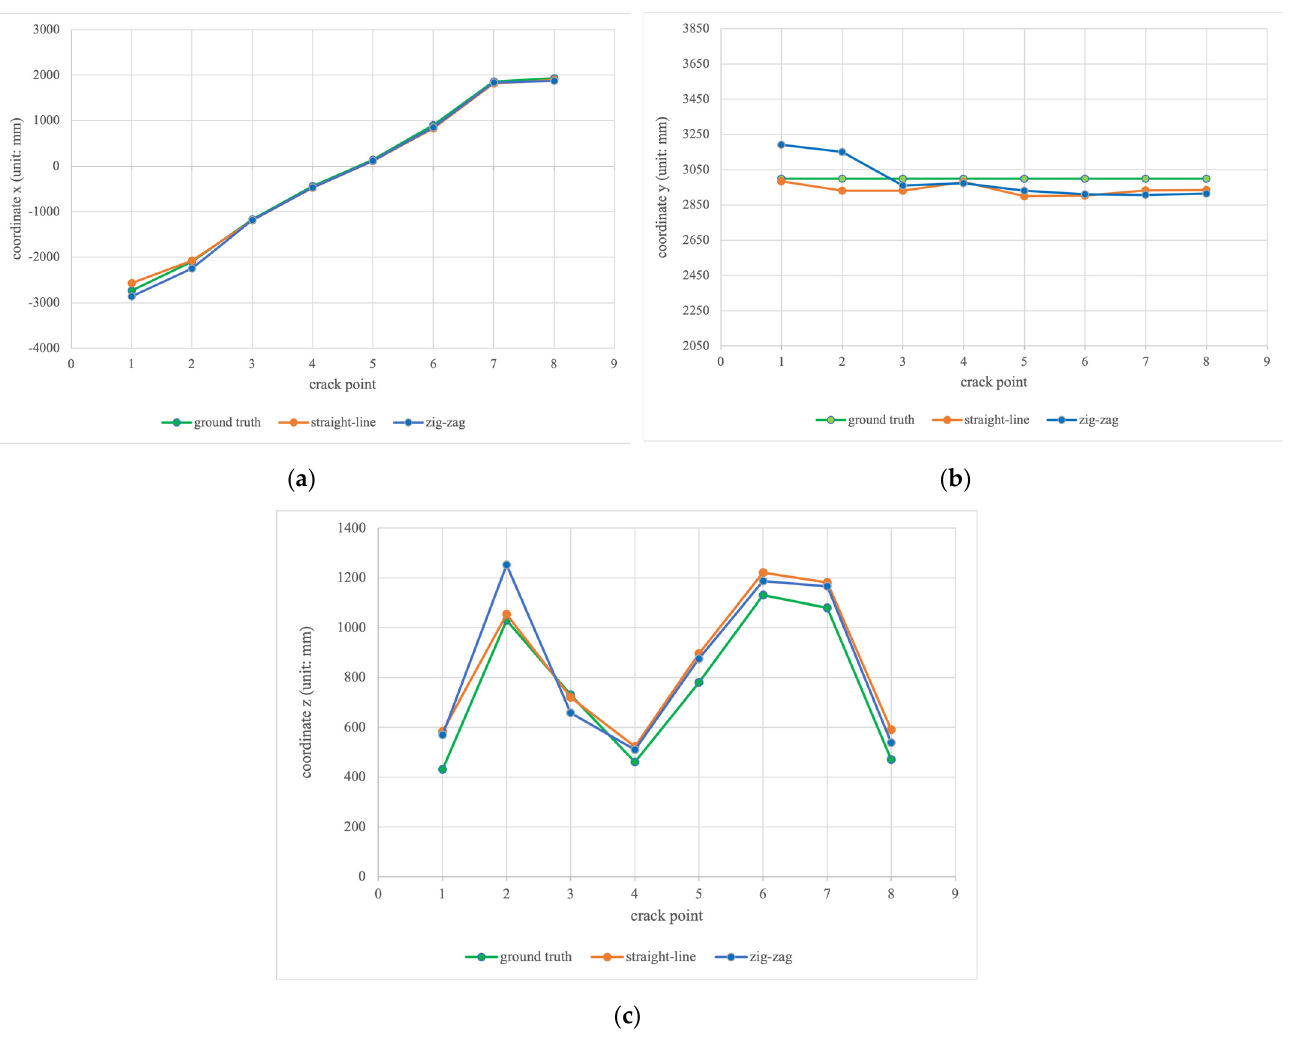
Figure 19. The localization results of ( a ) x coordinates; ( b ) y coordinates; ( c ) z coordinates on the training cracks.